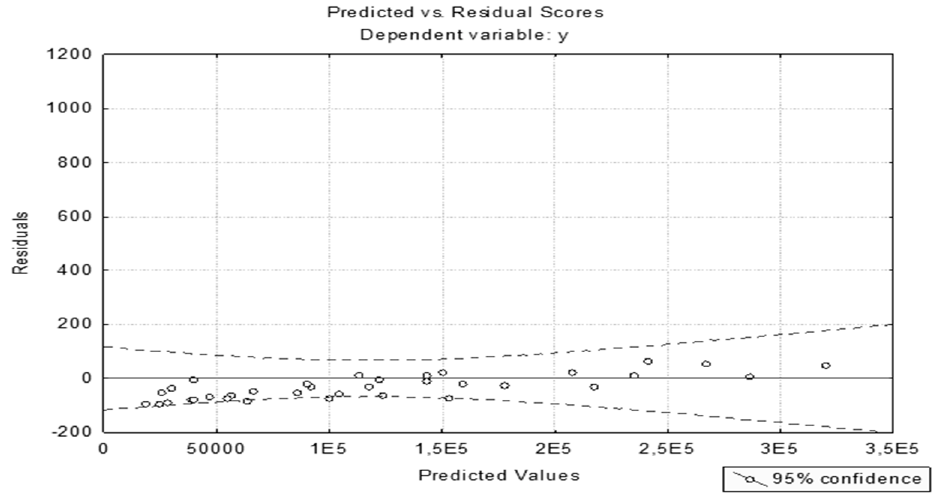
Figure 1. A matrix of scattering diagrams of independent variables of a multifactorial linear model of joint value created in the maritime port sector (in the package Statistics 8.0).